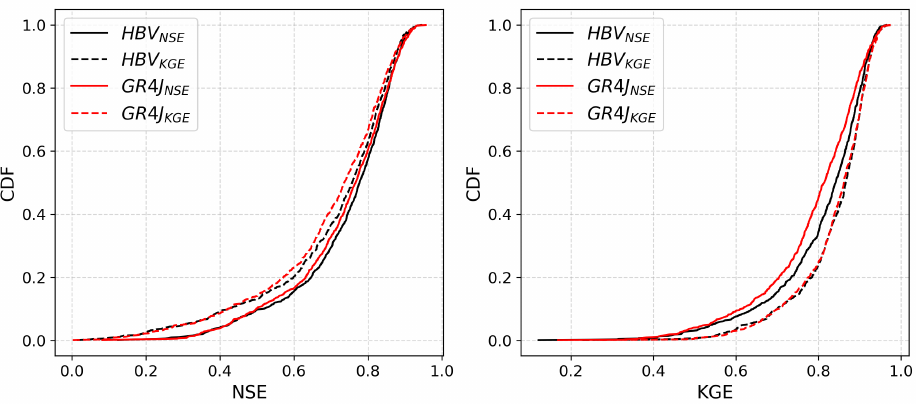
Figure 5. Cumulative density functions (CDF) for the NSE ( left plot ) and KGE ( right plot ) for all model